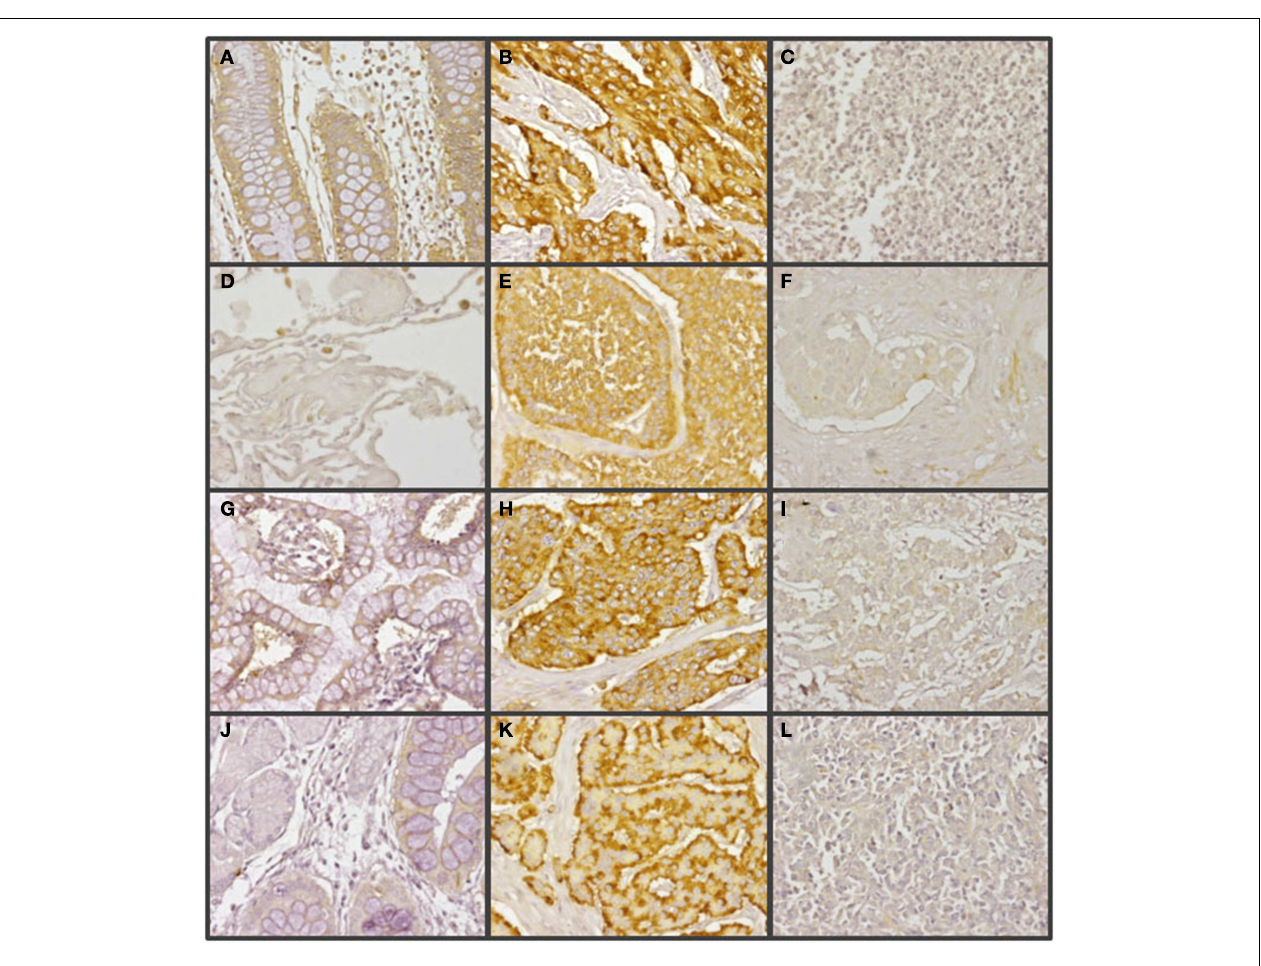
from colon (C) , lung (F) , stomach (I) , and pancreas (L) . Low-grade tumors exhibited markedly increased staining compared to normal tissue in both cytoplasm and cell membrane. By contrast, high-grade tumors showed a drastic decrease in expression. Magnification 200 ×